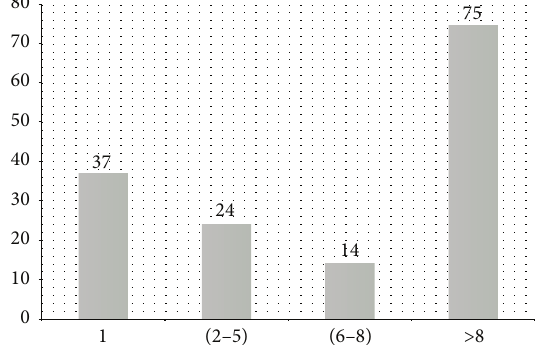
Figure 3: Frequency of the number of leiomyomatous nodules per patient in Pernambuco, Brazil.